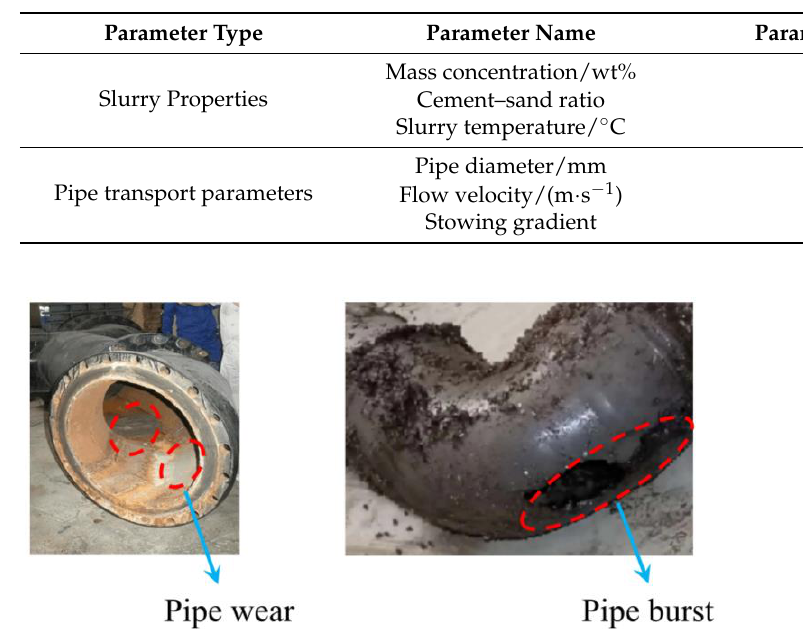
Figure 3. Wear diagram of backfill pipe.